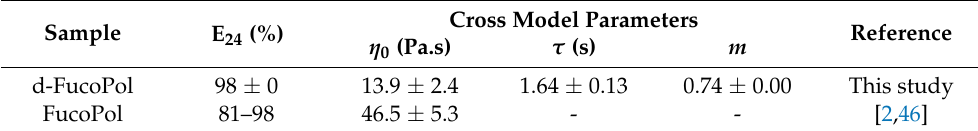
Table 4. Emulsification index (E 24 ) and Cross model parameters estimated for the emulsions prepared with the deacylated FucoPol and olive oil, at an oil/water (O/W) weight ratio of 3:2: η 0 —apparent viscosity of the first Newtonian plateau (Pa · s); τ —relaxation time (s); and m —dimensionless constant. Cross Model Parameters Sample E 24 (%)